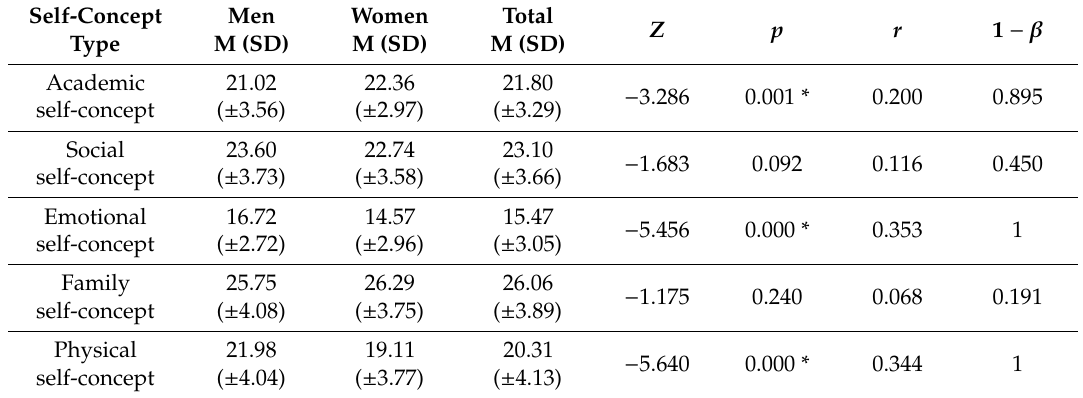
Table 2. U Mann–Whitney test relating self-concept to gender.